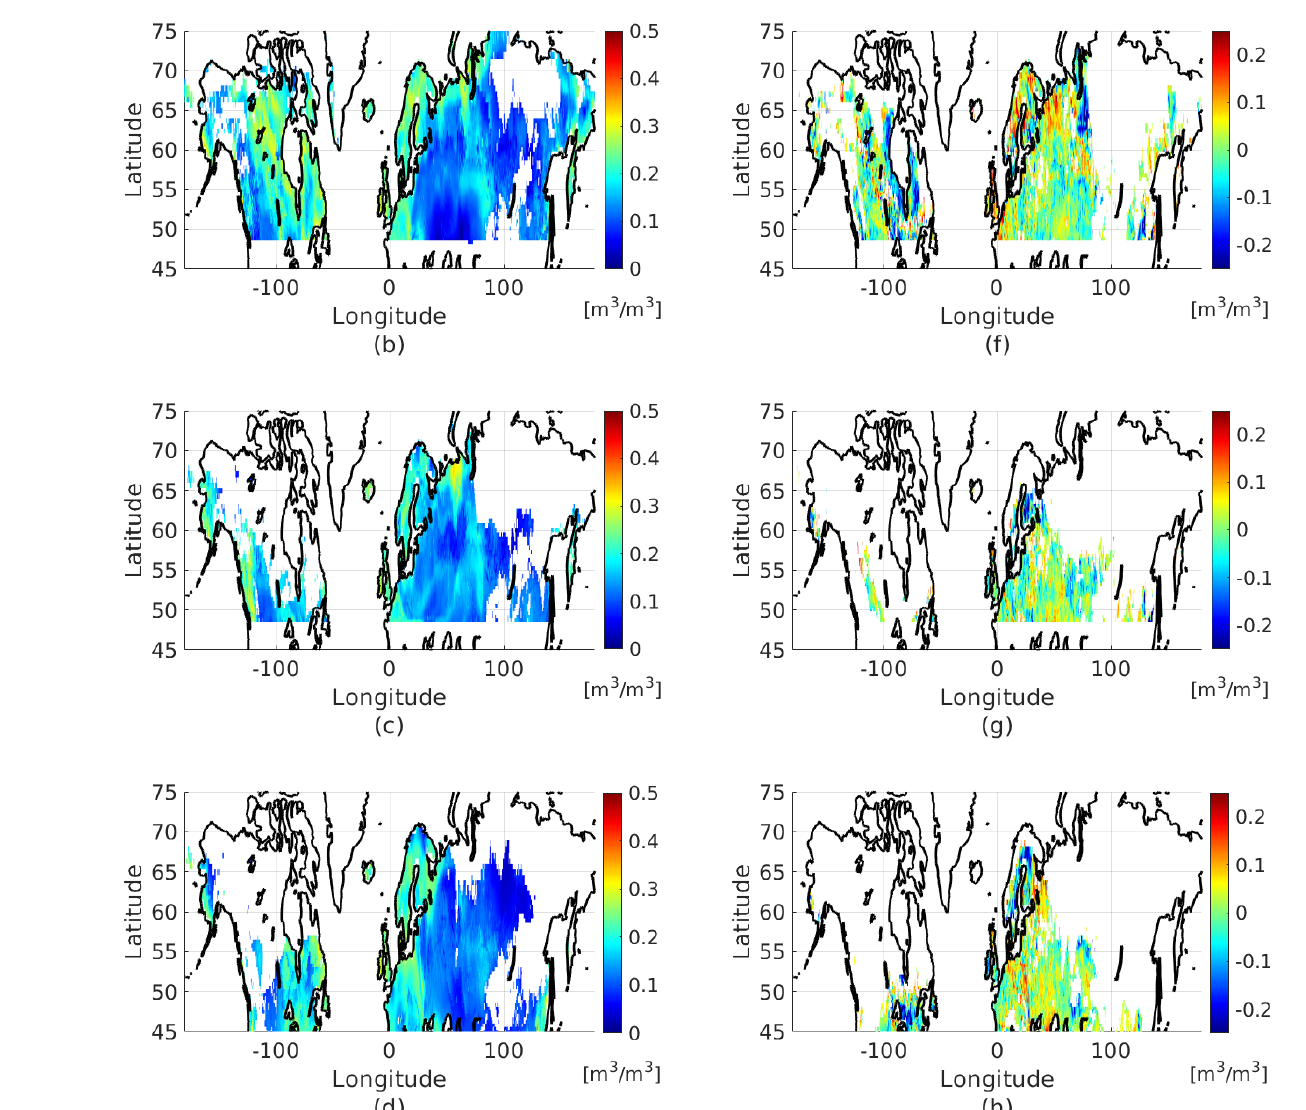
Figure 8. ( a – d ) FMPL-2/MWR down-scaled SM estimations corresponding to ( a ) 1–5 October 2020, ( b ) 10–15 October 2020, ( c ) 25–30 October 2020, and ( d ) 9–14 November 2020. ( e – h ) Errors with respect to the SMOS SM product, for the same date periods specified in ( a – d ). Note that, SMOS GT data are not available in regions that are blank (e.g., northern part of